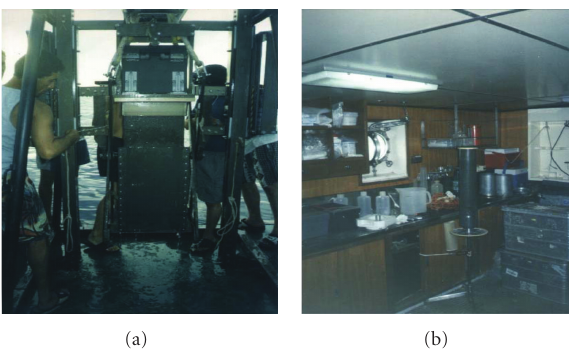
Figure 2: (a) A box corer for the collection of sediment, and (b) a device for sectioning sediment, on board of the research vessel of M.S.